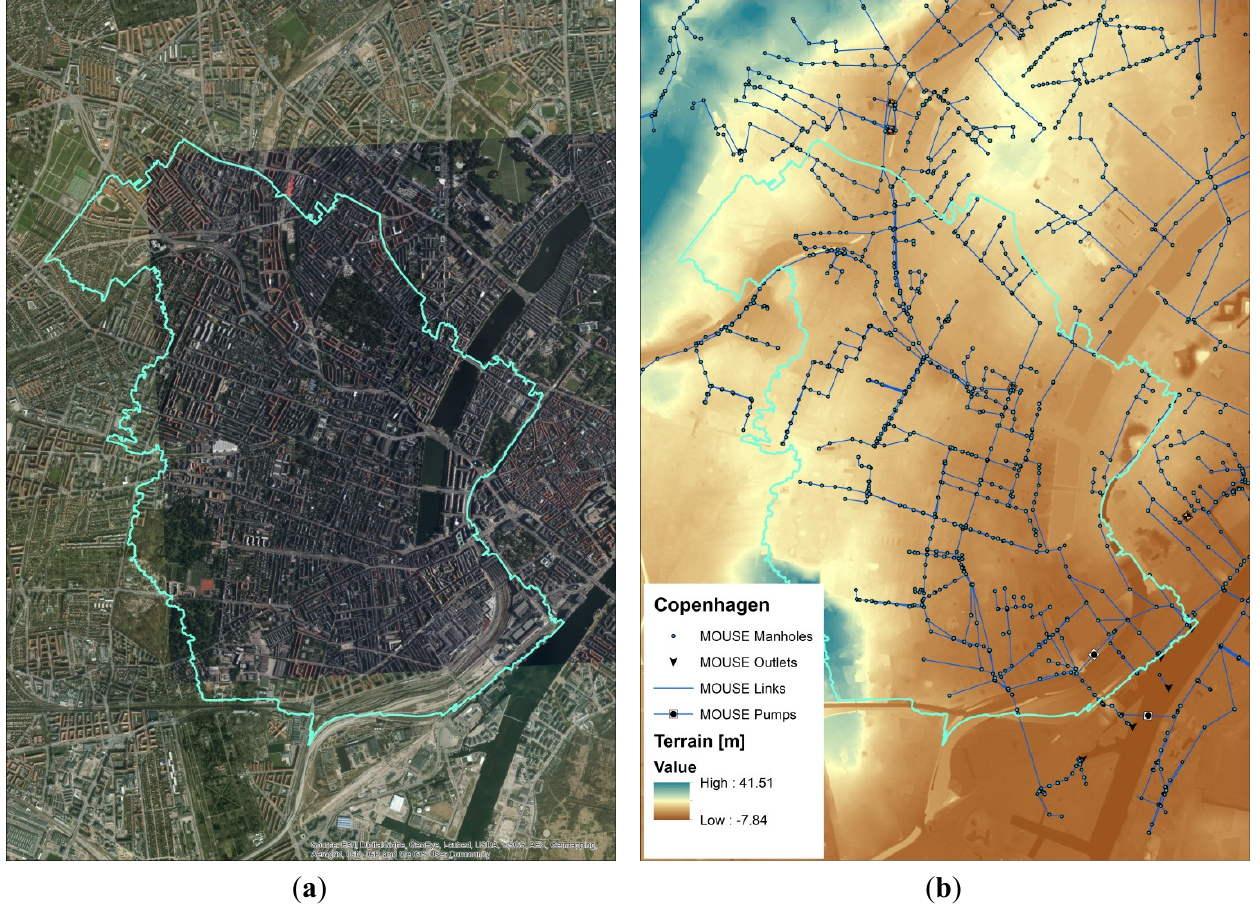
Figure 8. The study area used by Hede& Kolby [10] is located in central Copenhagen and